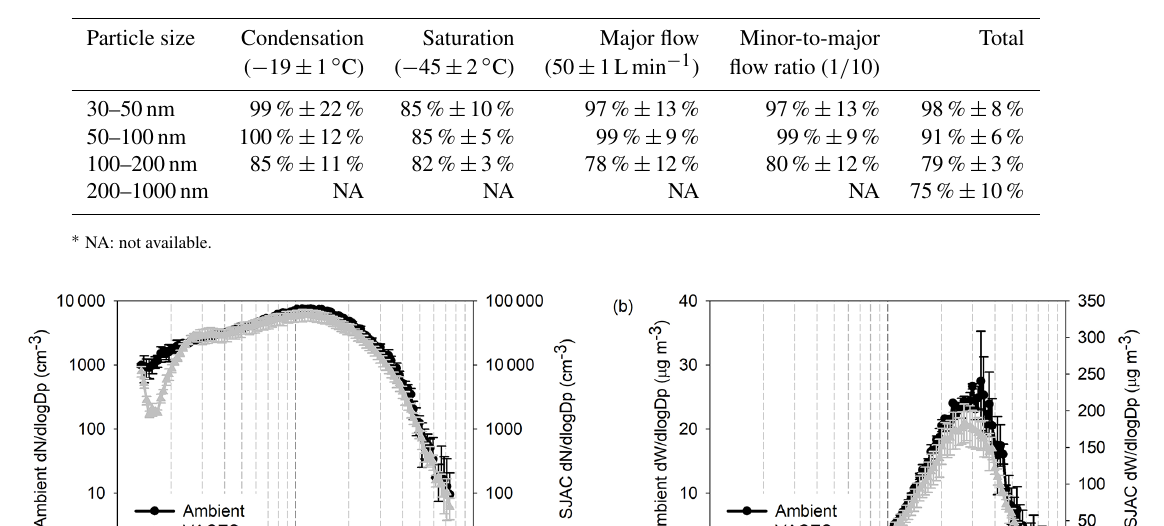
Table 1. Enrichment efficiency of ambient aerosols in VACES at different size ranges.